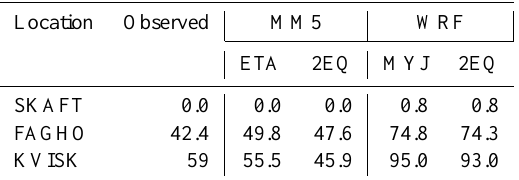
Figure 4: Zoomed in view of simulated surface wind speed [ms − 1 ] at lowest half-sigma level (approximately 40 m.a.g.) by MM5 (left panels) and WRF (right panels) at 16 September 2004, 0600 UTC. Top panels show results from the ETA and MYJ boundary layer schemes and the bottom panel shows results using the new two equation PBL model. The letters "BV" show the location of the vertical profile, along which the Brunt-Väisälä frequency in Table 4 is calculated. The upstream distance from point B to the lateral boundaries of the 1 km domain is approximately 60 km. Table 1. Observed and simulated accumulated precipitation [mm], between 15 September, 18:00 UTC and 16 September, 09:00UTC, at stations SKAFT, FAGHO and